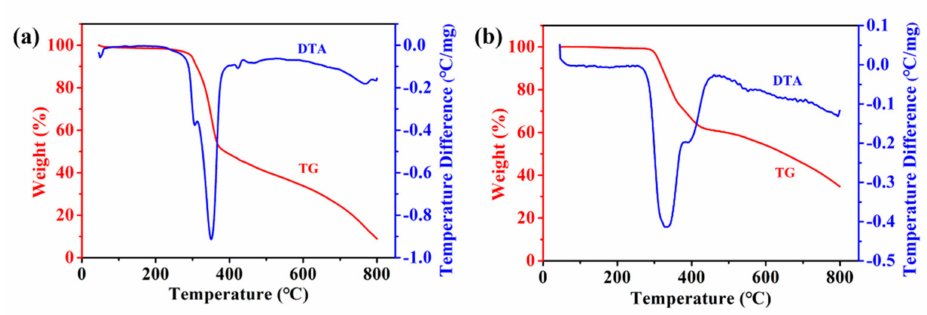
Figure 3. ( a ) TG–DTA curve of compound 1 ; and ( b ) TG–DTA curve of compound 2